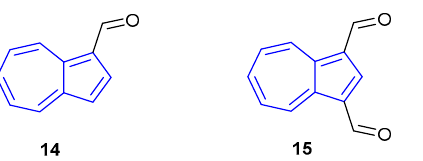
Figure 11. Fluorescent azulene aldehydes synthesised by Li, Gao and co-workers [58] .